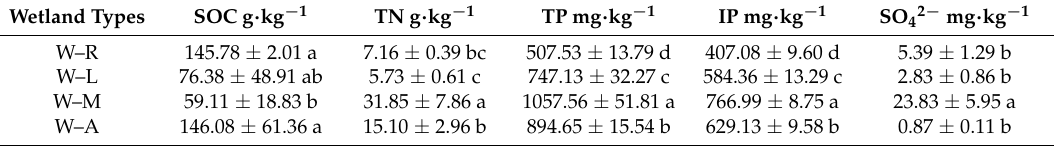
Table 2. Chemical characteristics of the four types of wetlands selected in the study.